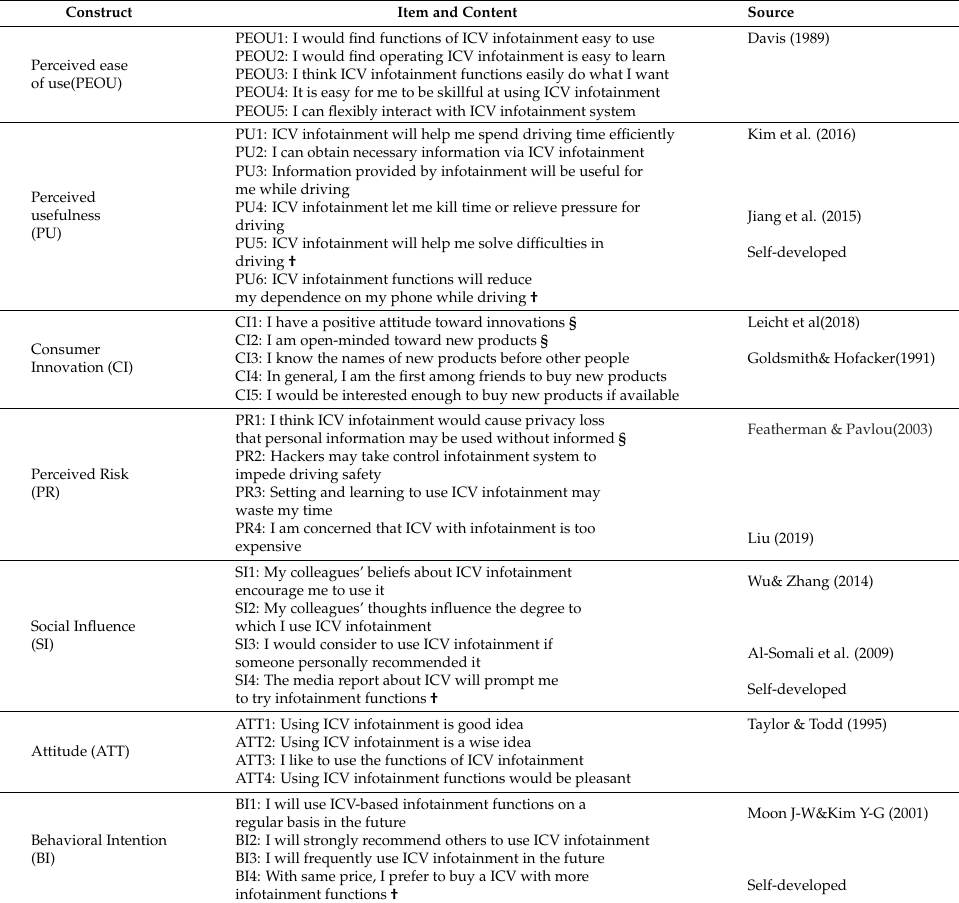
Table A1. Constructs and measurement items in the